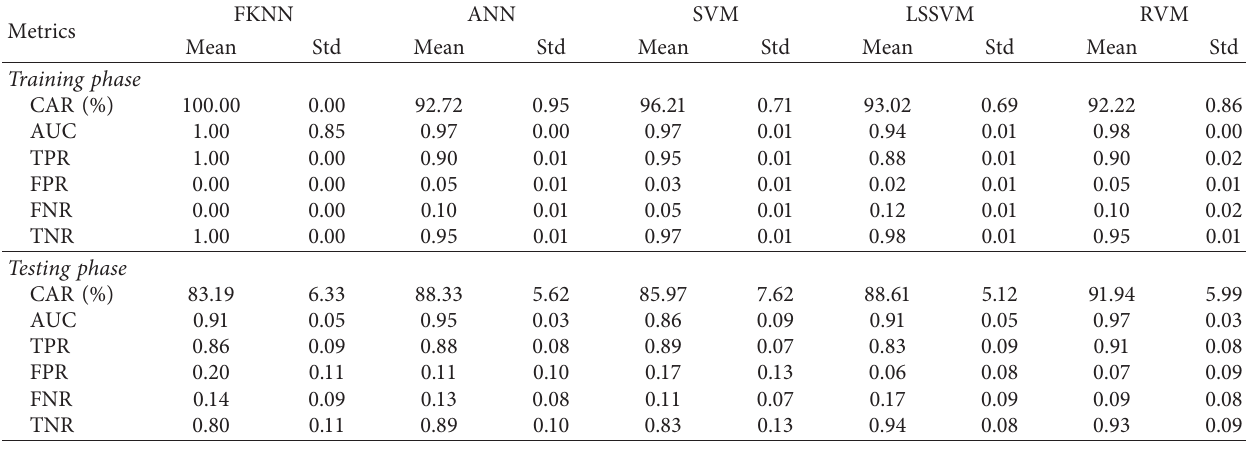
Table 2: Performance metrics of five soil erosion prediction